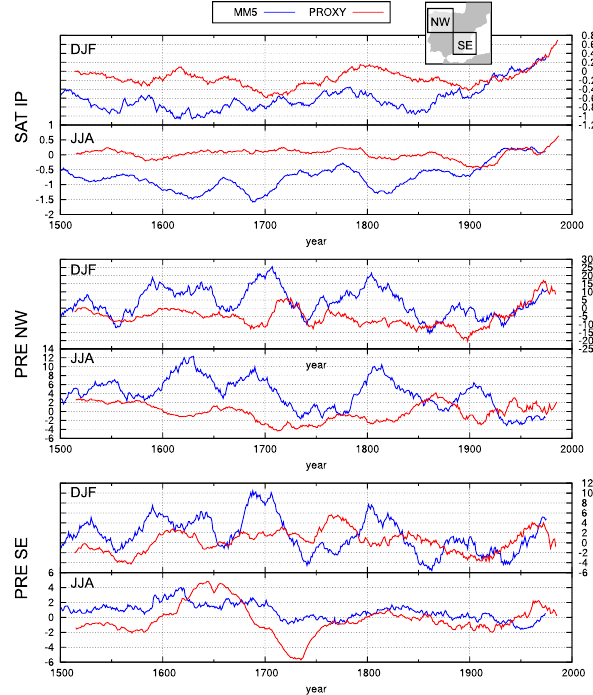
Fig. 15. Anomaly series of SAT over the IP (upper panel, in ◦ C) Northwest precipitation (middle panel, in mm/month) and South- east precipitation (lower panel, in mm/month) in winter (DJF) and summer (JJA), respectively. The NW and SE subdomains are represented in the grey map in the top-right corner of the figure. Red line represents the series for the reconstructions and blue line for ECHO-G+MM5. Ocean grid-cells are excluded in the calcu- lations. Anomalies are calculated with respect to the 1900–1990 period, and a 31-years running mean have been applied to all